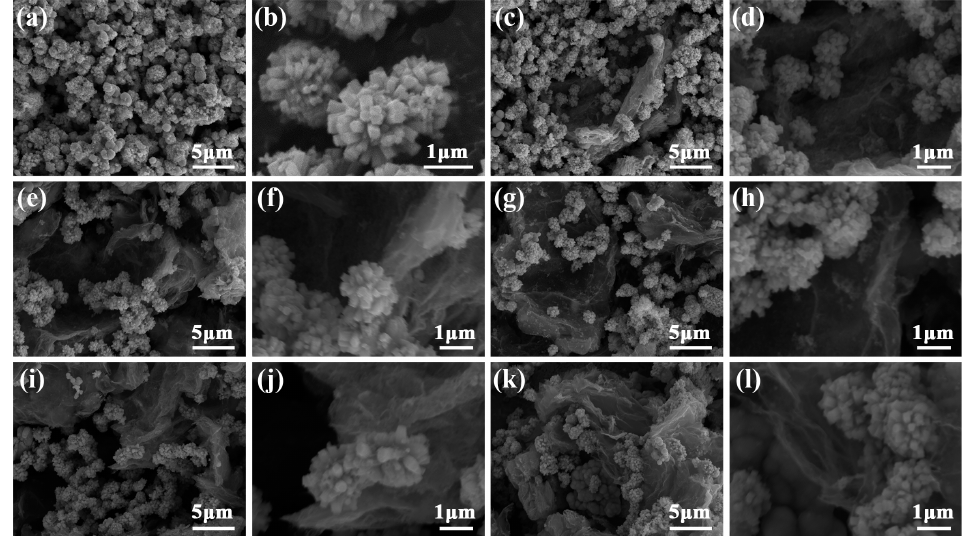
Figure 3. FE-SEM images of ( a , b ) In 2 O 3 , ( c , d ) 1-rGO/In 2 O 3 , ( e , f ) 3-rGO/In 2 O 3 , ( g , h ) 5-rGO/In 2 O 3 , ( i , j ) 7-rGO/In 2 O 3 , and ( k , l ) 10-rGO/In 2 O 3 .